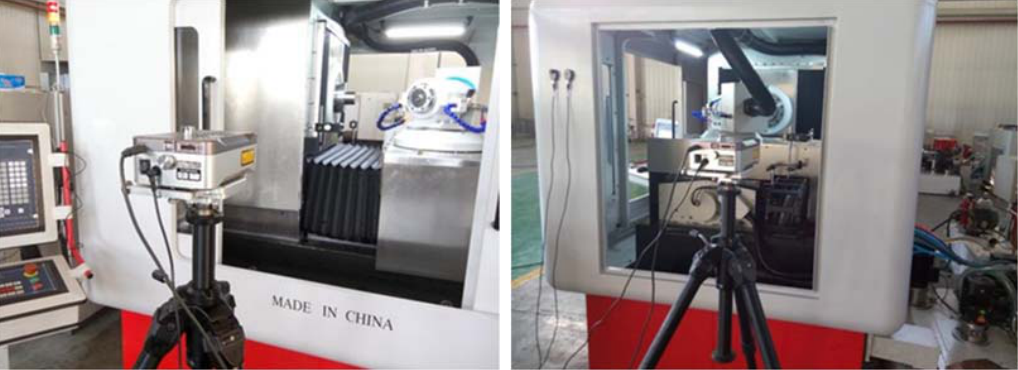
Figure 8. X ‐ axis and Z ‐ axis straightness, positioning accuracy, and repeated positioning accuracy test.